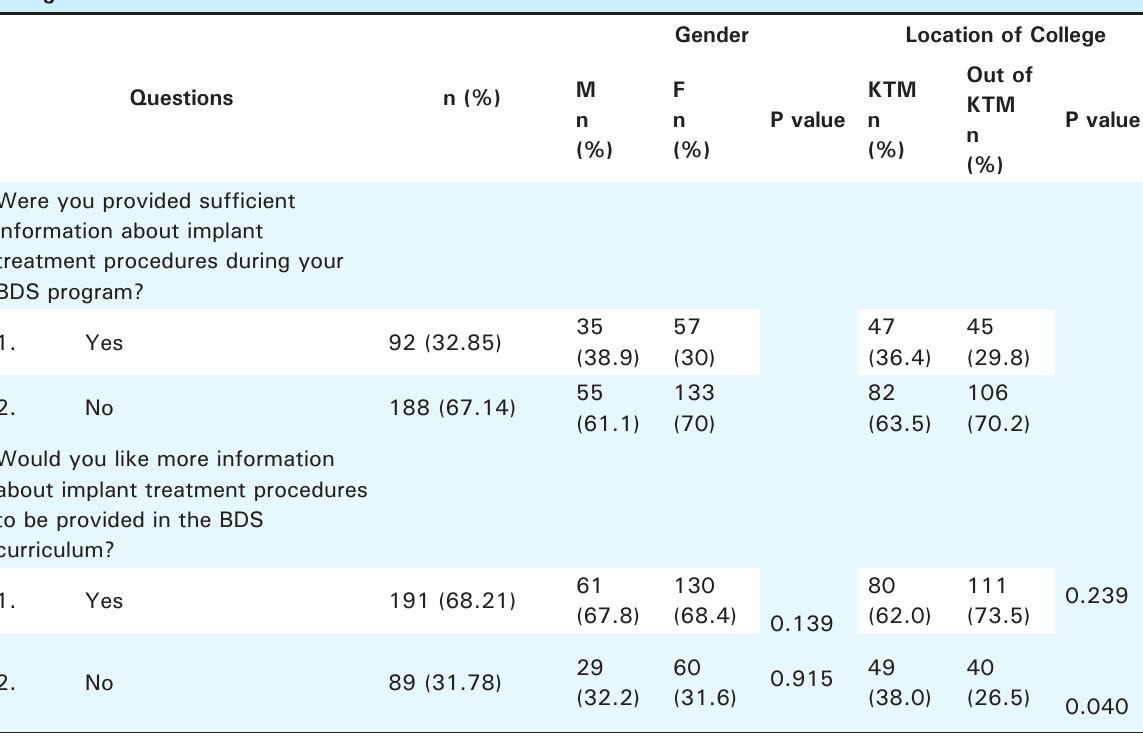
Table 4. Responses to the 10 th and 11 th Questions and their associations with gender and location of the college.